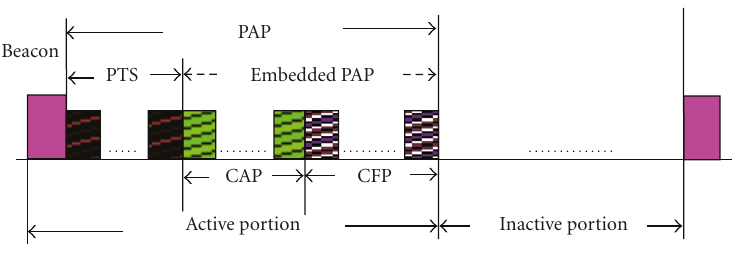
Figure 2: NICT MAC superframe structure.